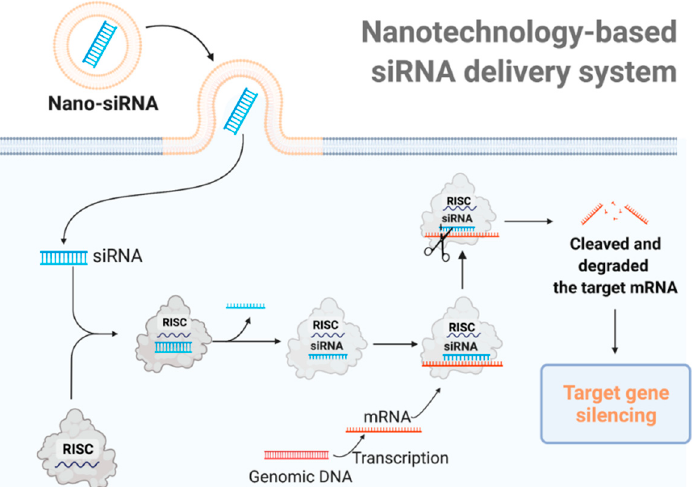
Figure 1. The mechanism of nanotechnology-based siRNA delivery systems. Utilizing delivery materials, siRNA can be delivered directly into the cell. The siRNA is integrated into the RNA- induced silencing complex (RISC) and the sense (passenger) strand is degraded by the RISC protein Argo-2. The remaining antisense strand acts as a guide for recognizing the complementary messenger RNA. The activated RISC–siRNA complex binds to and degrades the target mRNA, leading to the silence of the target